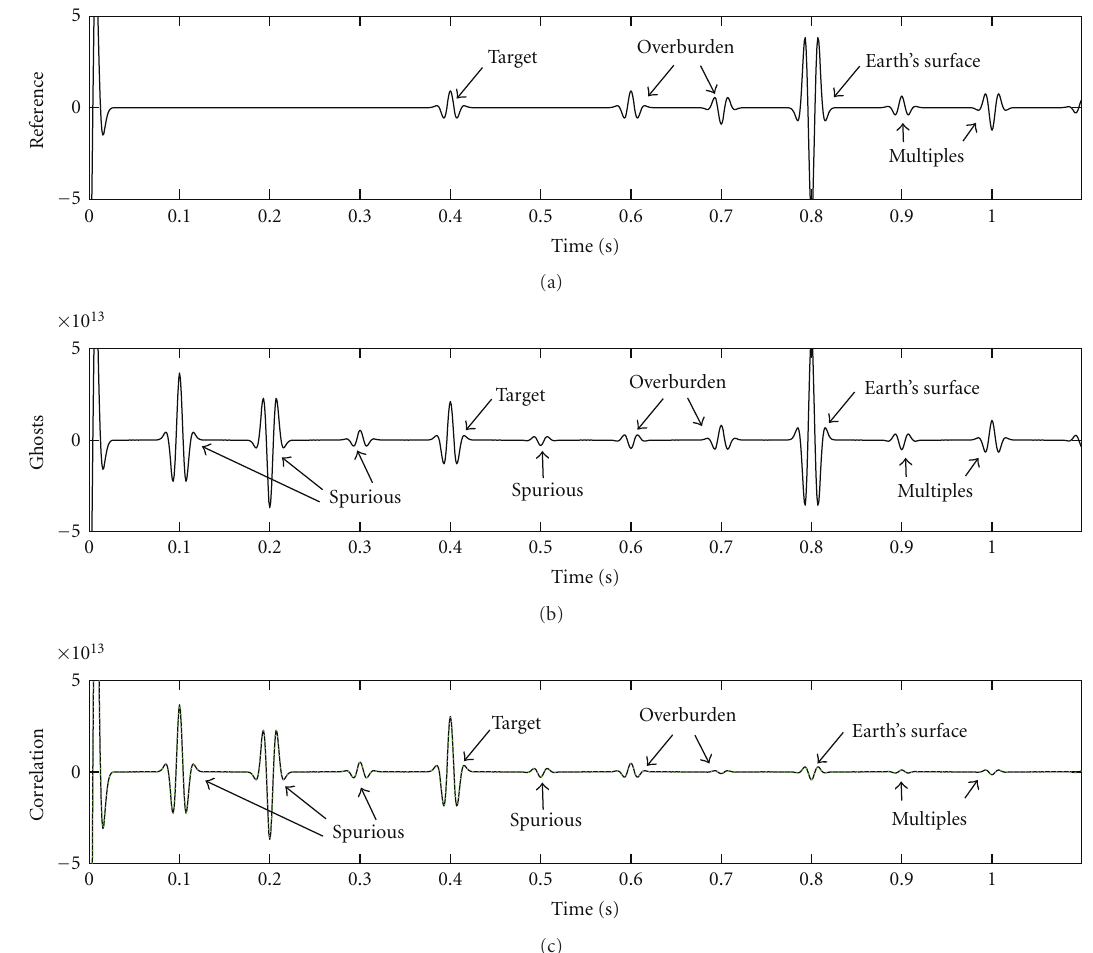
Figure 7: Cross-correlation of full fields for model D: (a) reference response by placing an active source at the virtual source location x A ; (b) computed ghost terms g S + g O ; (c) causal part of the correlation function C (black) and the sum of reference response + ghosts (dashed